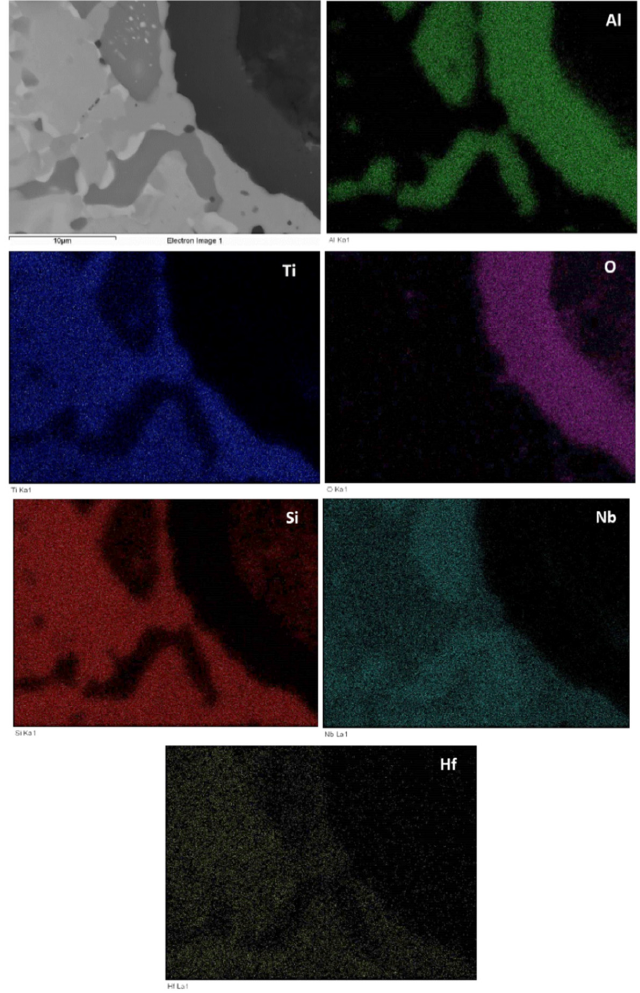
Figure 14. BSE image and X-ray elemental maps of scale formed on the alloy Nb 1.3 Si 2.4 Ti 2.4 Al 3.5 Hf 0.4 at 1200 °C.